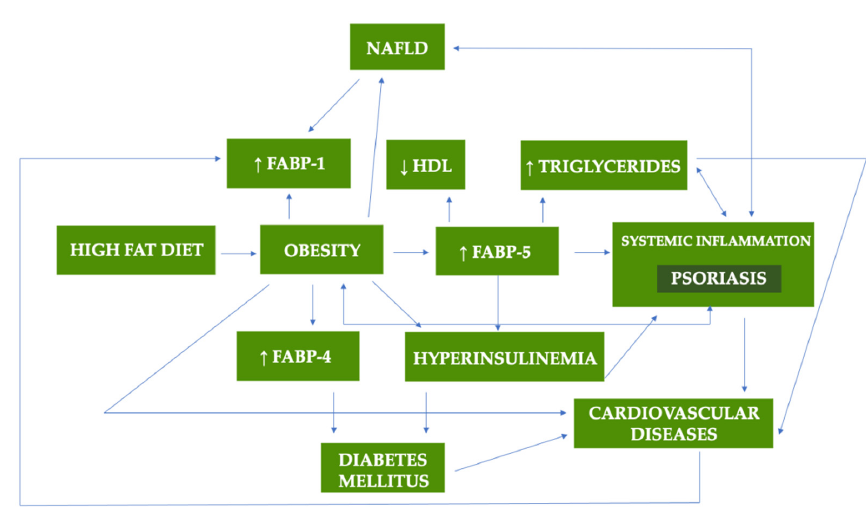
Figure 2. The potential role of FABPs in metabolic disorders and psoriasis [20,21,62–64].